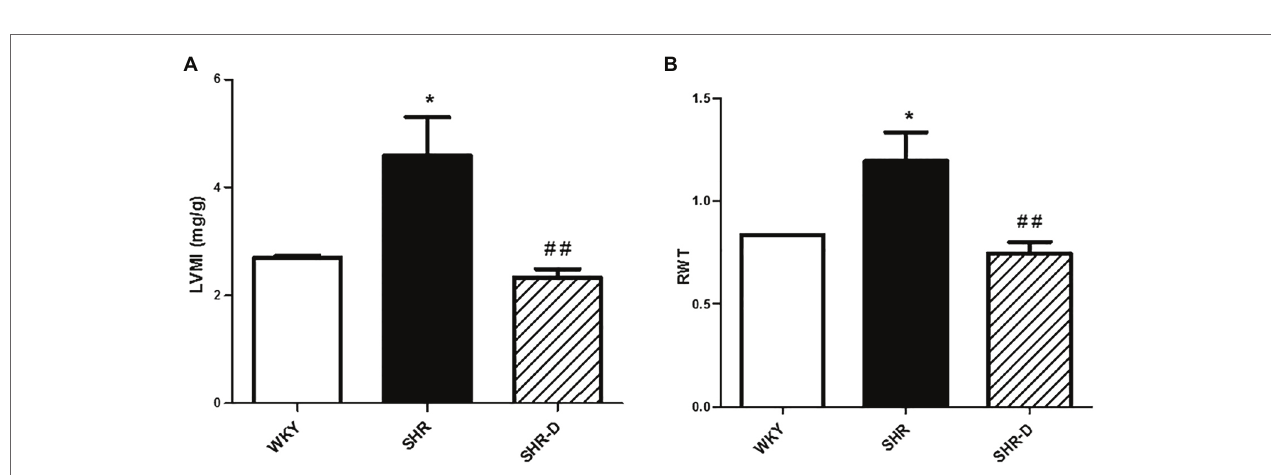
FIGURE 2 | Parameters indicative of left ventricular geometry. (A) Left ventricular mass index (LVMI) and (B) relative wall thickness (RWT) measurements from Wistar-Kyoto rats (WKY) treated with vehicle, spontaneously hypertensive rats (SHR) treated with vehicle, and spontaneously hypertensive rats treated with dronedarone (SHR-D). Statistically significant differences among WKY, SHR, and SHR-D are shown (* p < 0.05 vs. WKY; and ## p < 0.01 vs. SHR). Values are shown as mean ± SEM ( n = 8 per